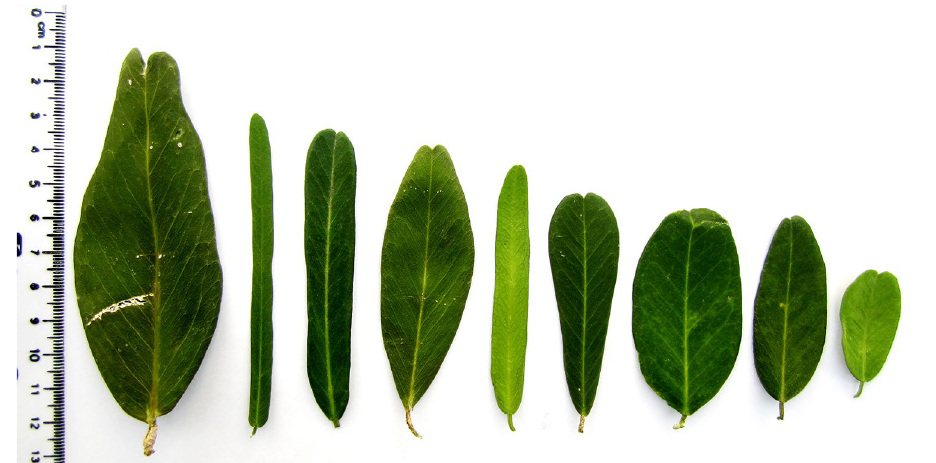
Figure 3. The morphological variation of leaves among accessions of P. trimera (Oliv.) Burkill. Leaves of P. trimera showing oblong, elongate, obovate, ovate, oval, elip, roundish forms with rounded or obtuse apexes. Different forms of leaves were sometimes found in a single individual